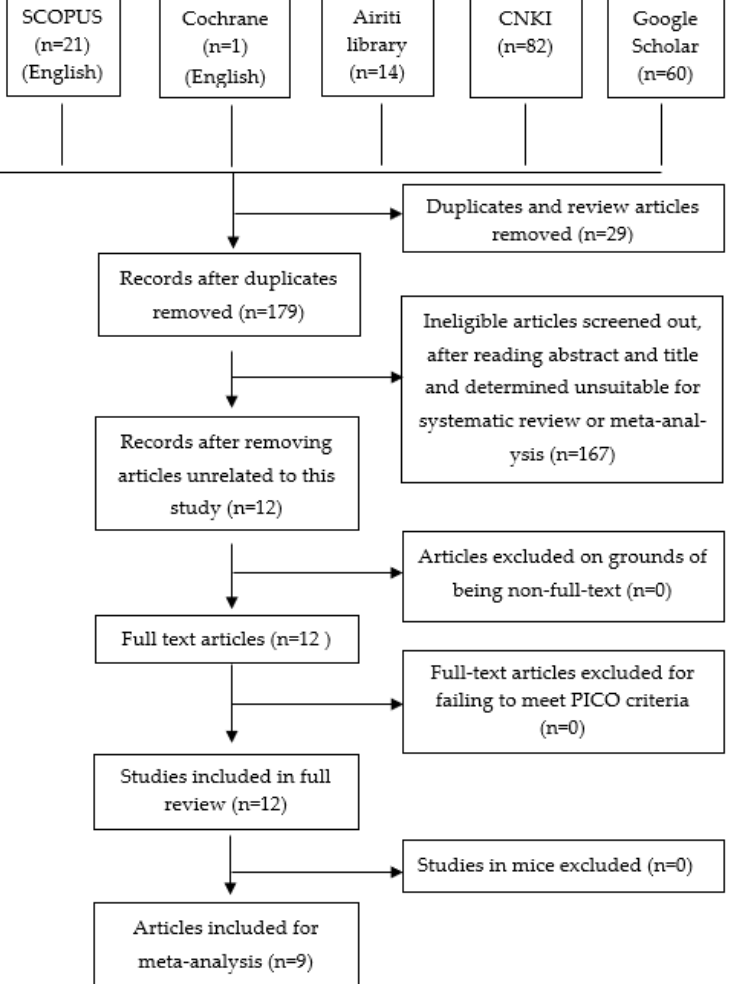
Figure 1. Flowchart of search results and article retrieval.